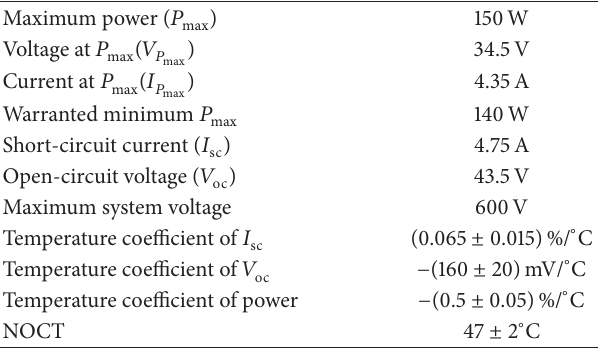
Table 1: Electrical characteristic of bpsx150PV